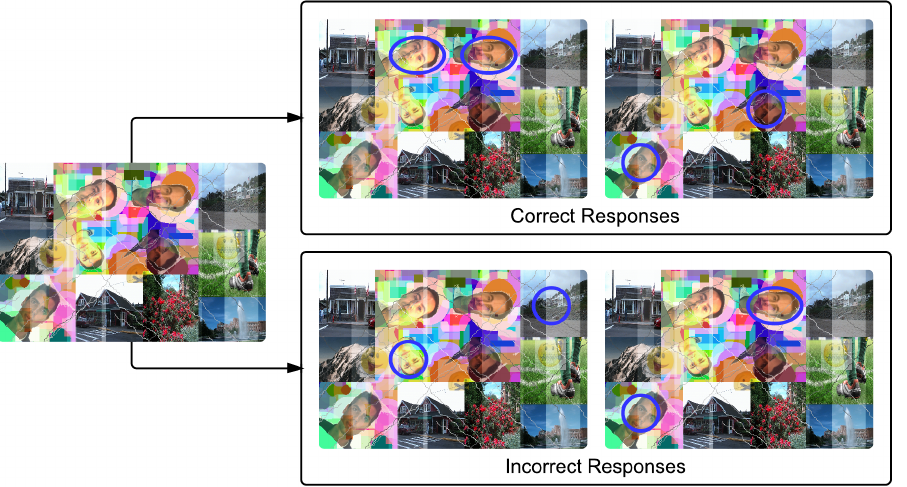
Figure 4. Example of correct and incorrect responses to the proposed FR-CAPTCHA. It can be solved correctly if and only if a matching pair of human faces is selected by the user. Each blue circle represents a user response. As shown, selecting two face images of the same person is considered as a correct response, while selecting a non-face image or two images of different persons is considered an incorrect response.